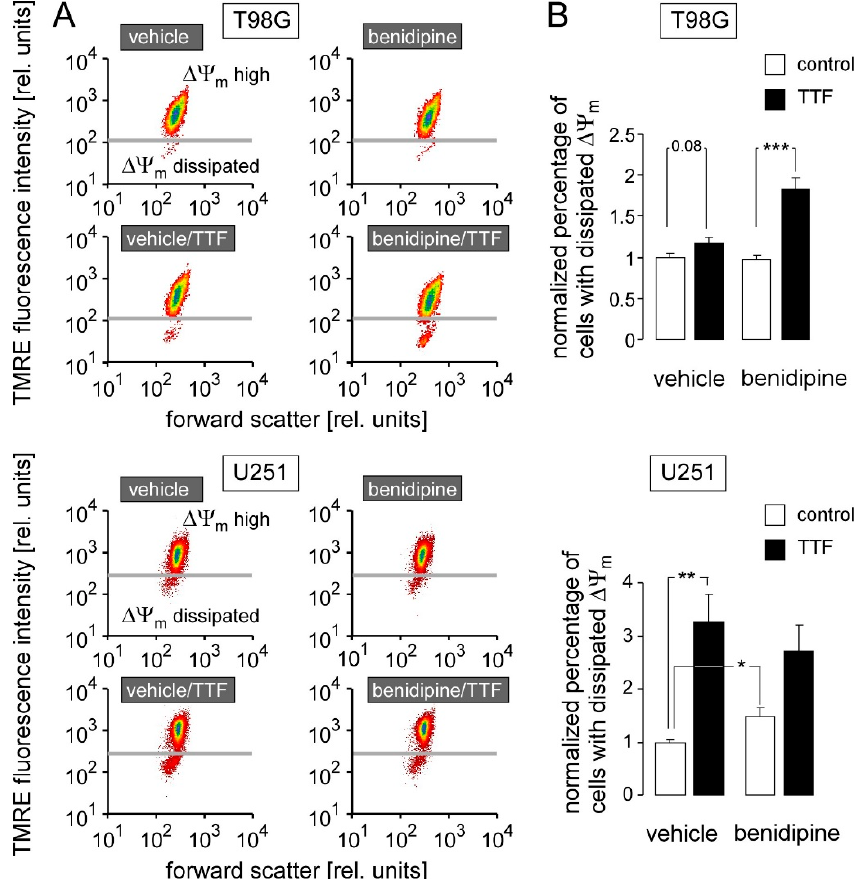
Figure 8. Benidipine augments TTFields-induced breakdown of the inner mitochondrial membrane potential ( ∆Ψ m ) in T98G cells. ( A ) Dot plots showing forward scatter and TMRE fluorescence intensity of T98G (top) and U251 cells (bottom) treated for 7 day with 0 (control) or 2.5 V/cm TTFields (200 kHz) in the absence (vehicle) or presence of benidipine (1 µ M). ( B ) Mean ( ± SE; n = 12–22) normalized percentage of T98G (top) and U251 (bottom) cells with dissipated ∆Ψ m after 5–7 days of treatment with 0 (control) or 1 V/cm TTFields (TTF, 200 kHz) and 0 or 1 µ M benidipine (absolute values of the control situation were 4.5 ± 1.0% for T98G and 4.3 ± 1.3% for U251). *, ** and *** indicate 3 p ≤ 0.05 and 3 p ≤ 0.01, respectively, Welch-corrected t -test and Bonferroni correction for three pairwise comparisons (vehicle/control vs. benidipine/control, vehicle/control vs. vehicle/TTFields, and benidipine/control vs. benidipine/ TTFields). Number in ( B , top) indicates p value.